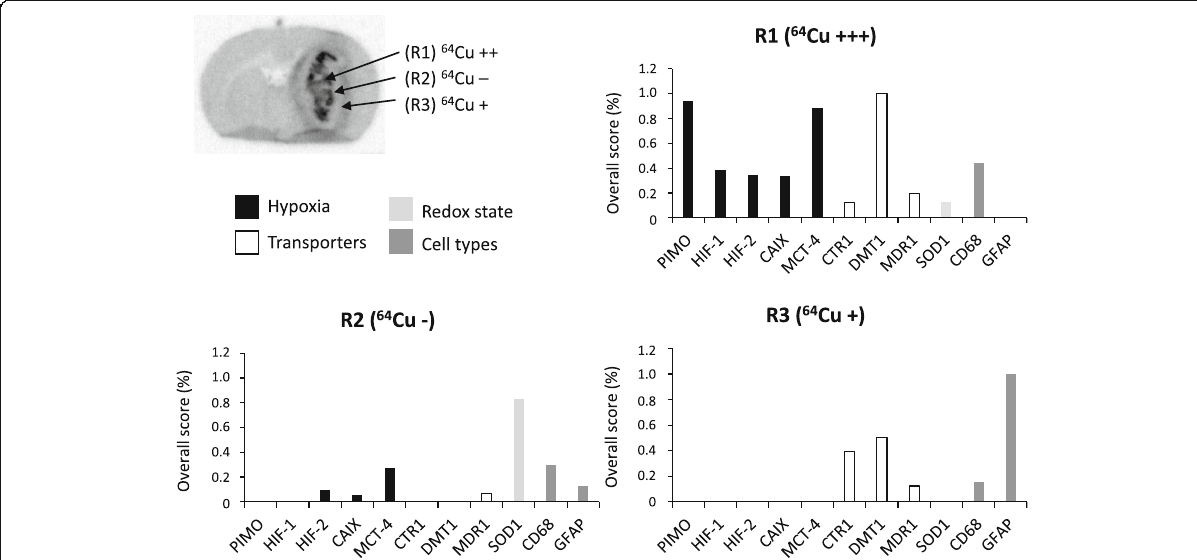
Fig. 5 Quantification of immunostaining for hypoxia, transporters, redox state, and cell types according to the spatial distribution of 64 Cu uptake. For each region defined on the autoradiography (R1 ( 64 Cu++), R2 ( 64 Cu − ), and R3 ( 64 Cu+)), an overall score was measured by multiplying the number of positive samples and the intensity score for each immunolabeling ( n = 9